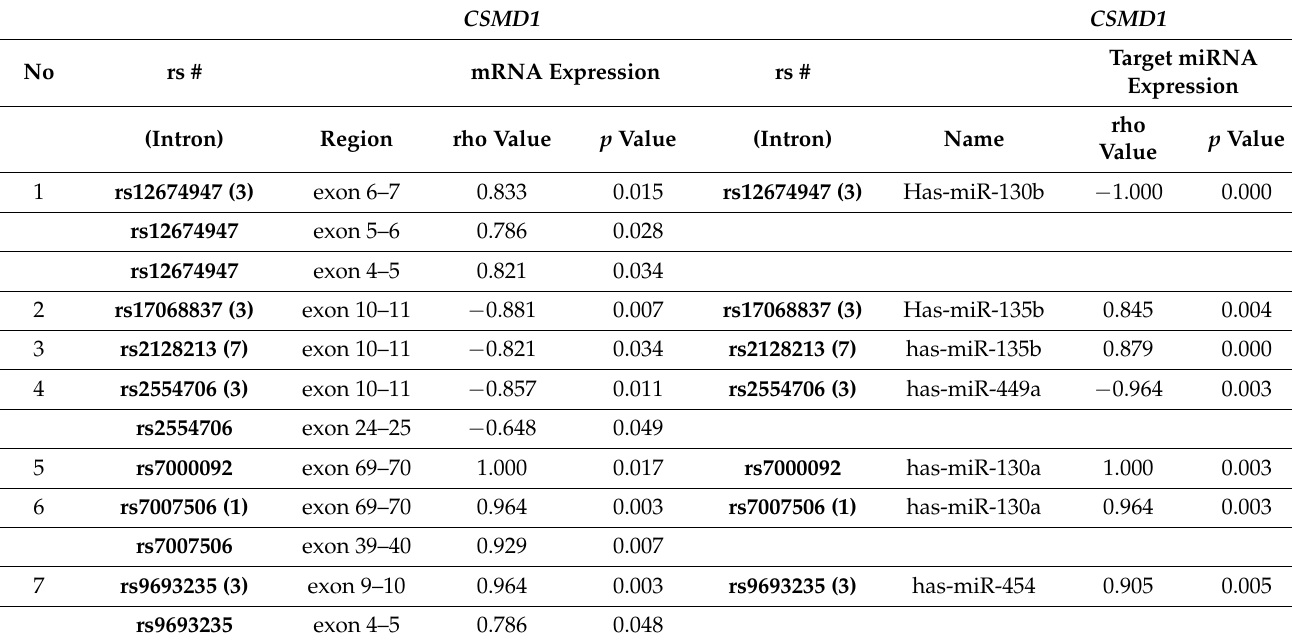
Table 2. The seven non-coding SNPs with somatic CN alterations were significantly correlated with both expressions of CSMD1 and its target miR in ESCC. CSMD1